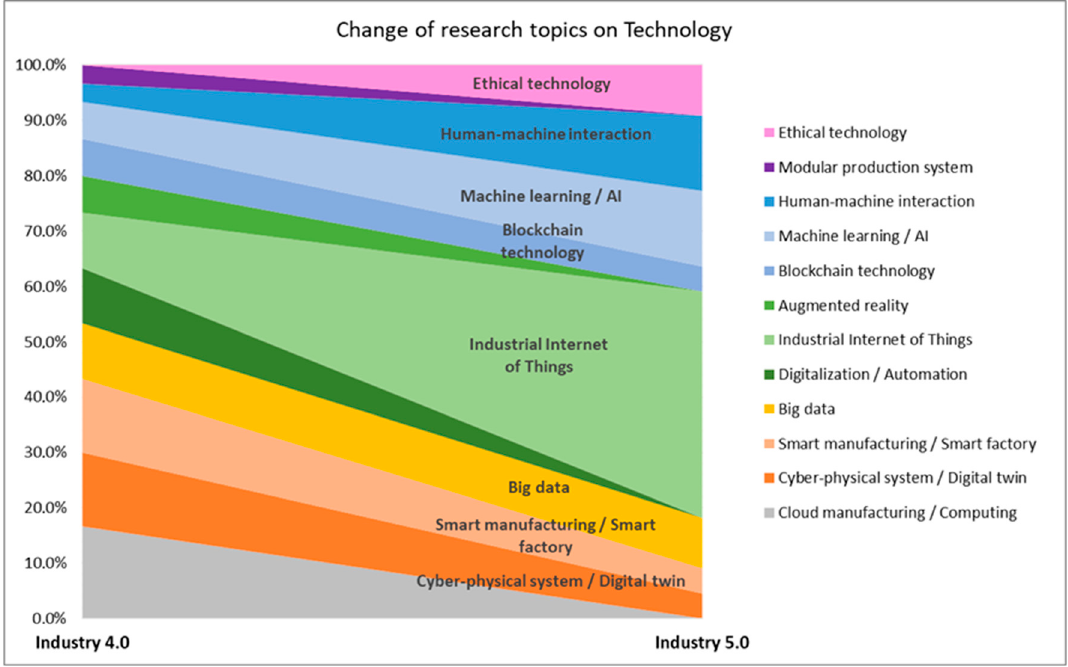
Figure 7. From Industry 4.0 toward Industry 5.0: Change of research topics on technology.